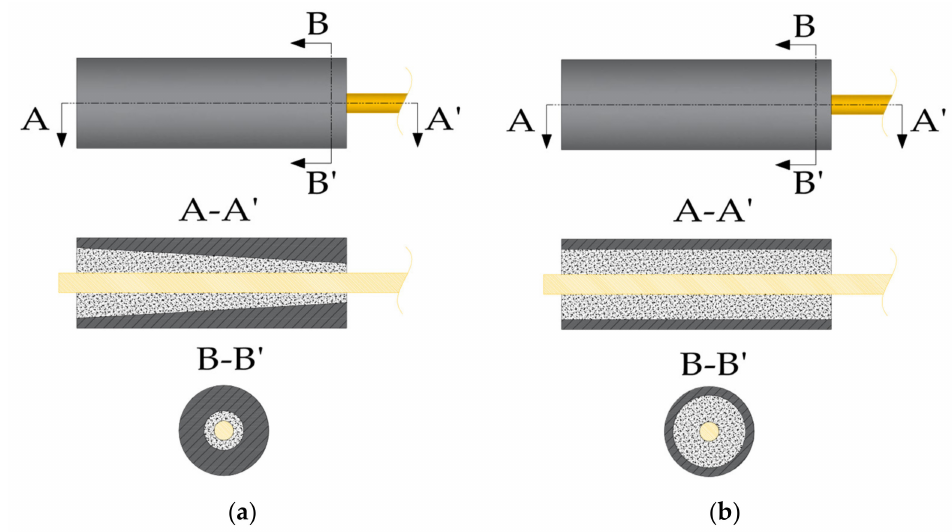
Figure 1. Examples of bonded anchorages with internal surface ( a ) tapered or ( b ) not tapered. The socket is filled with either resin or mortar. In mechanical anchorages, the FRP cable is kept stuck to the device throughout normal pressure, and the consequent friction, eventually coupled with cohesion, contrasts the applied axial load. Mechanical anchorages can be classi- fied as (a) clamping (Figure 2), (b) spike (Figure 3), and (c) split wedge (Figure 4) systems.